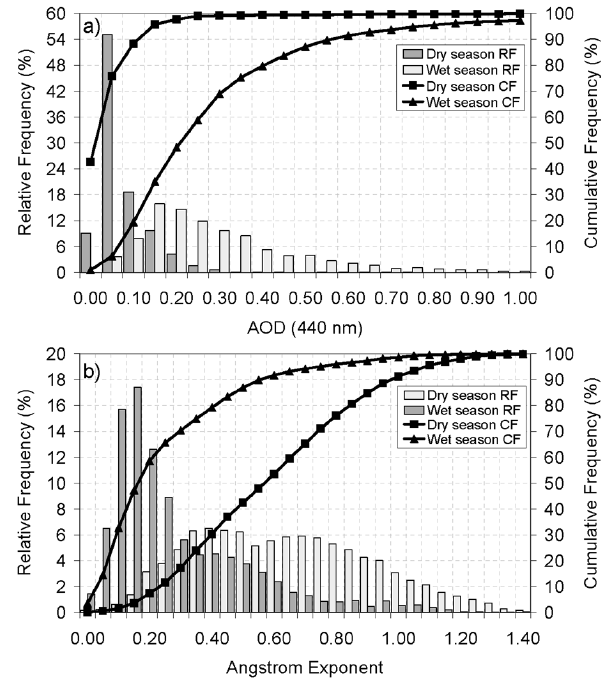
Figure 5. Relative frequency (RF) and cumulative frequency (CF) of (a) AOD at 440nm and (b) AE in the range 440–870nm at Tamanrasset. Histograms are shown separately for the dry and the wet seasons (refer to legend for colour and symbol description). AOD and AE are dimensionless